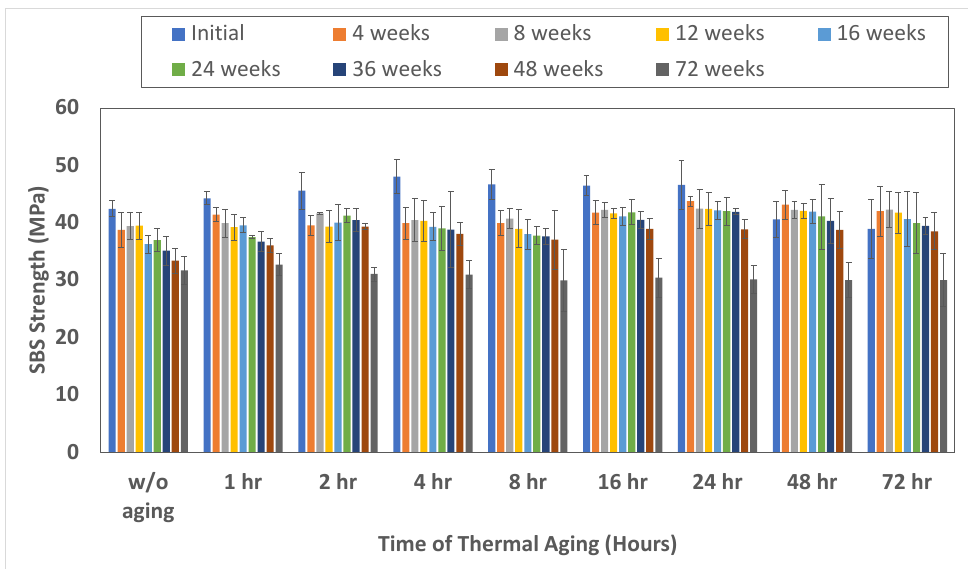
Figure 10. SBS strength as a function of time of immersion and period of prior thermal aging at 232 °C.